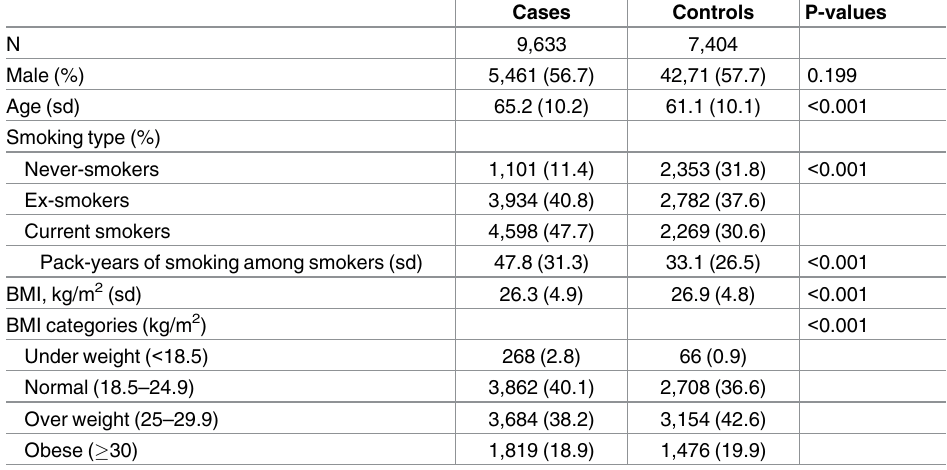
Table 1. Characteristics of 17,037 European-descent subjects in the OncoArray Project and epidemi- ologic data.